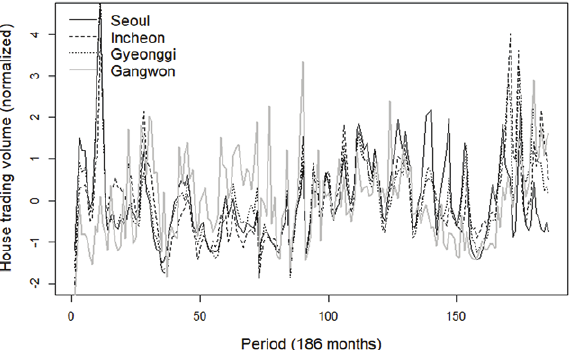
Figure 4. Fluctuations in house trading volumes between Jan. 2006 and Jun. 2021